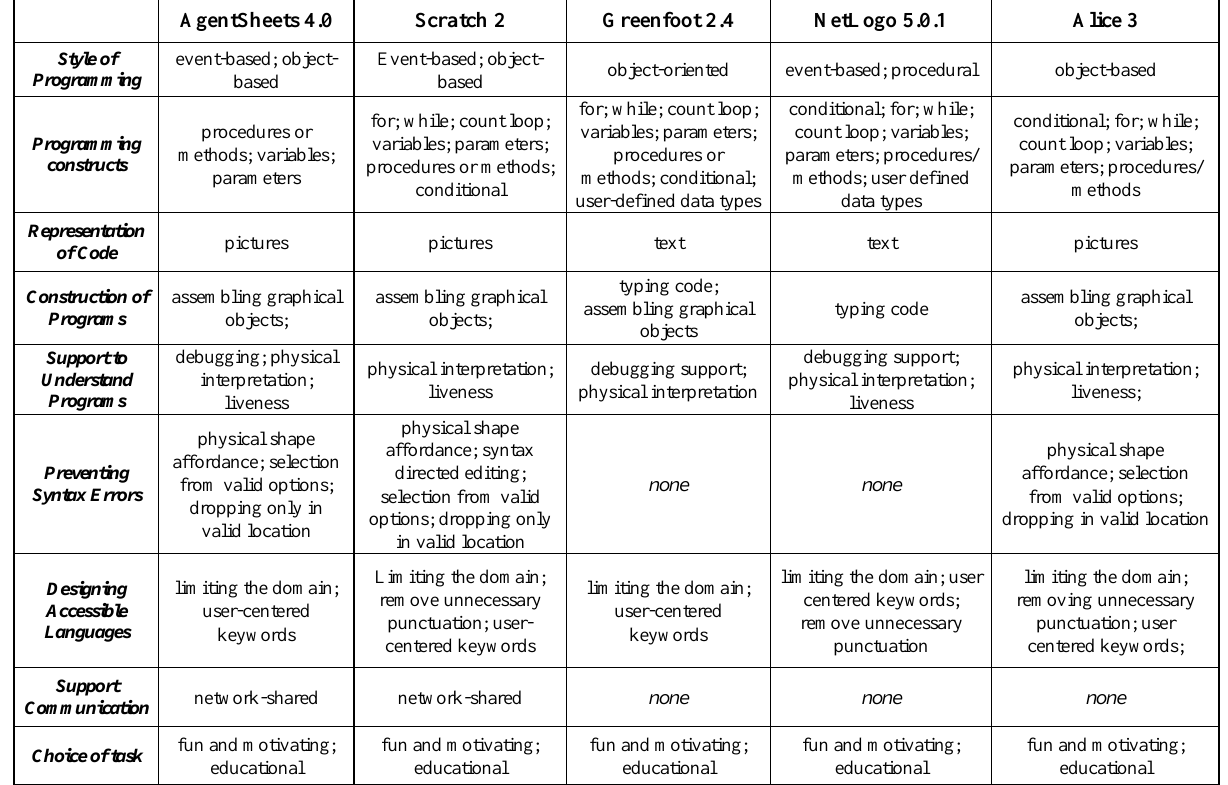
TABLE II. C OMPARISON BETWEEN ANALYZED PROGRAMMING LANGUAGES BASED ON FRAMEWORK FROM [19]. AgentSheets